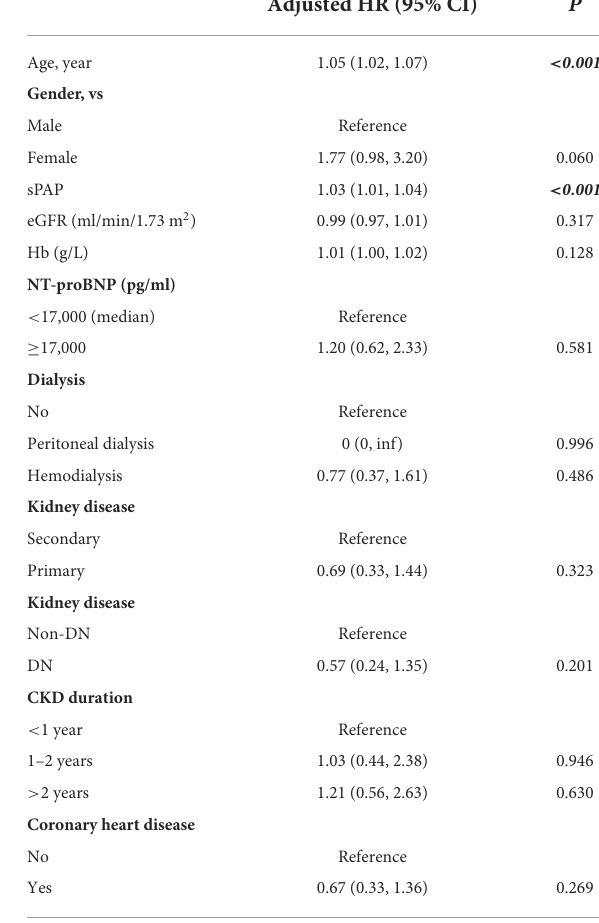
TABLE 5 Multivariable Cox regression analysis of risk factors associated with death in all CKD with PH